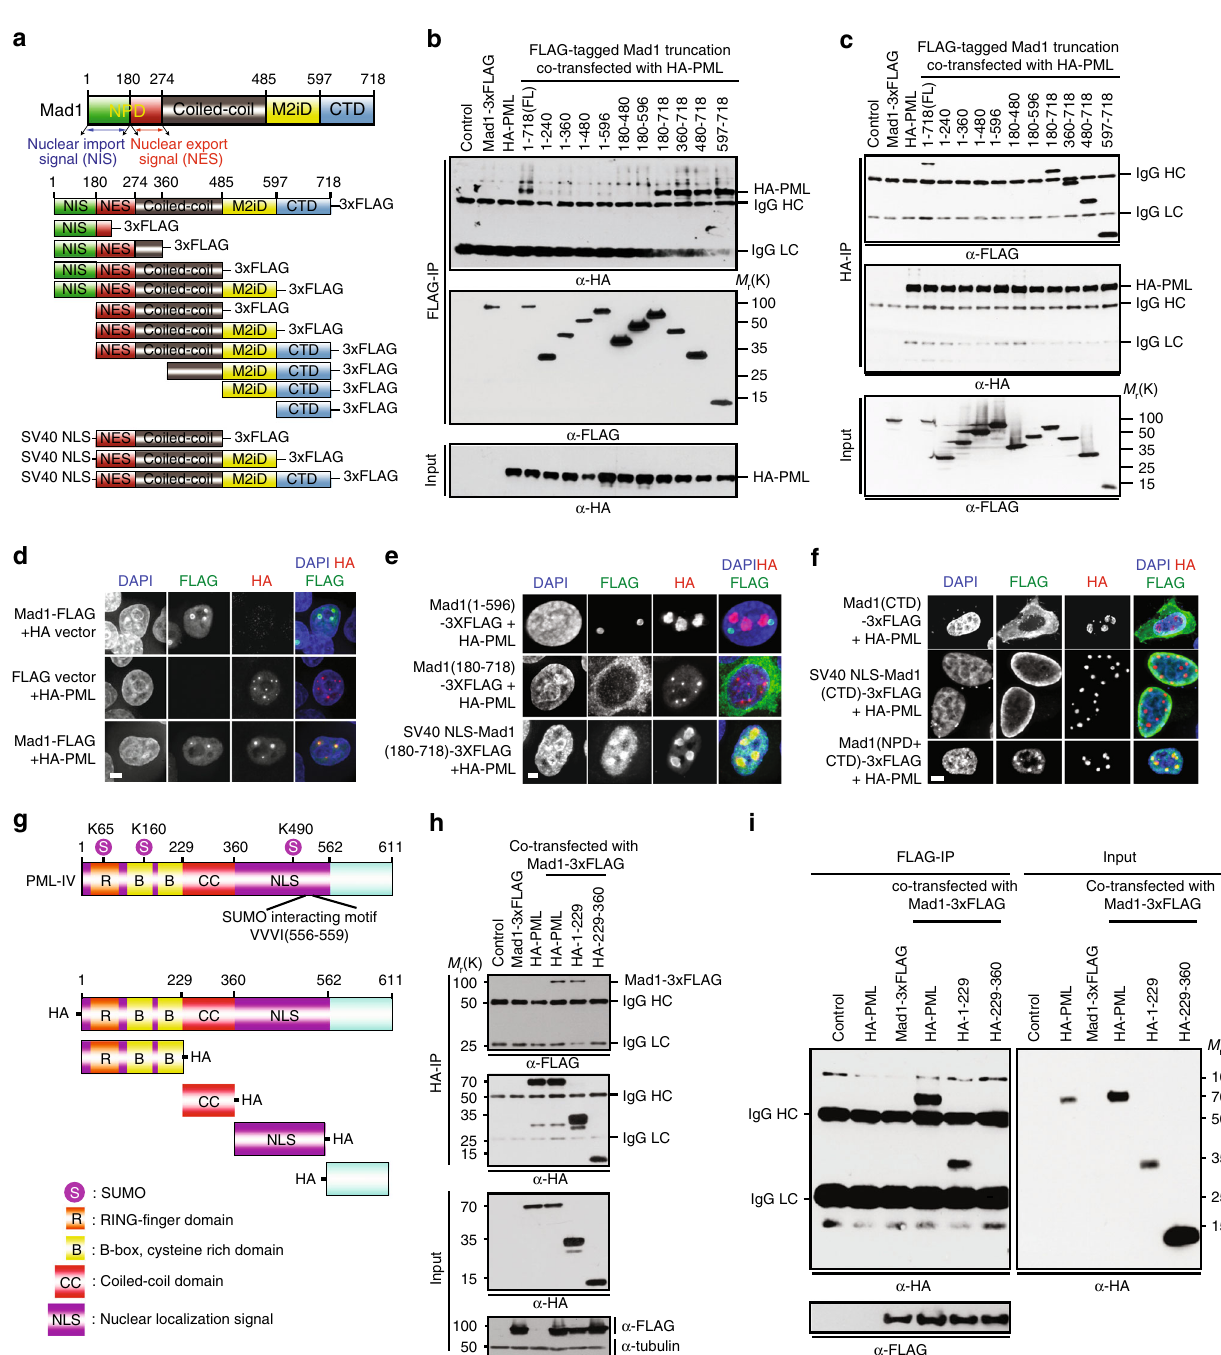
Fig. 2 The C-terminal domain (CTD) of Mad1 interacts with the N-terminus of PML. a Schematic of Mad1 and the Mad1 fragments tested. NIS